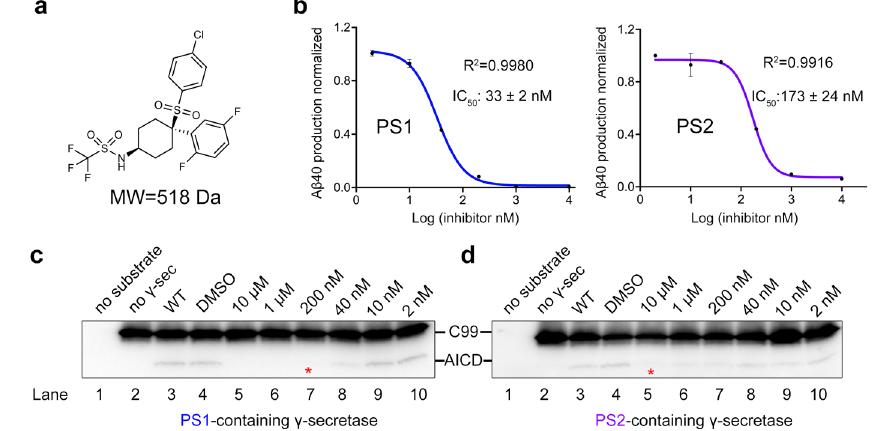
Fig. 1 | MRK-560 is a PS1-selective γ -secretase inhibitor. a Chemical structure of MRK-560. b MRK-560 preferentially inhibits the PS1-containing γ -secretase (short as the PS1-complex) in vitro. Quanti fi cation of A β 40 production using the Alpha- LISAassay yielded the IC 50 of 33±2nM and 173±24nM for PS1- and PS2-complex, respectively. Data arepresented asmeanvalues±SD. c , d MRK-560ismorepotent forinhibitingproductionoftheintracellulardomainofAPP-C99(AICD)byPS1than by PS2. Release of AICD in the presence of decreasing concentrations of MRK-560